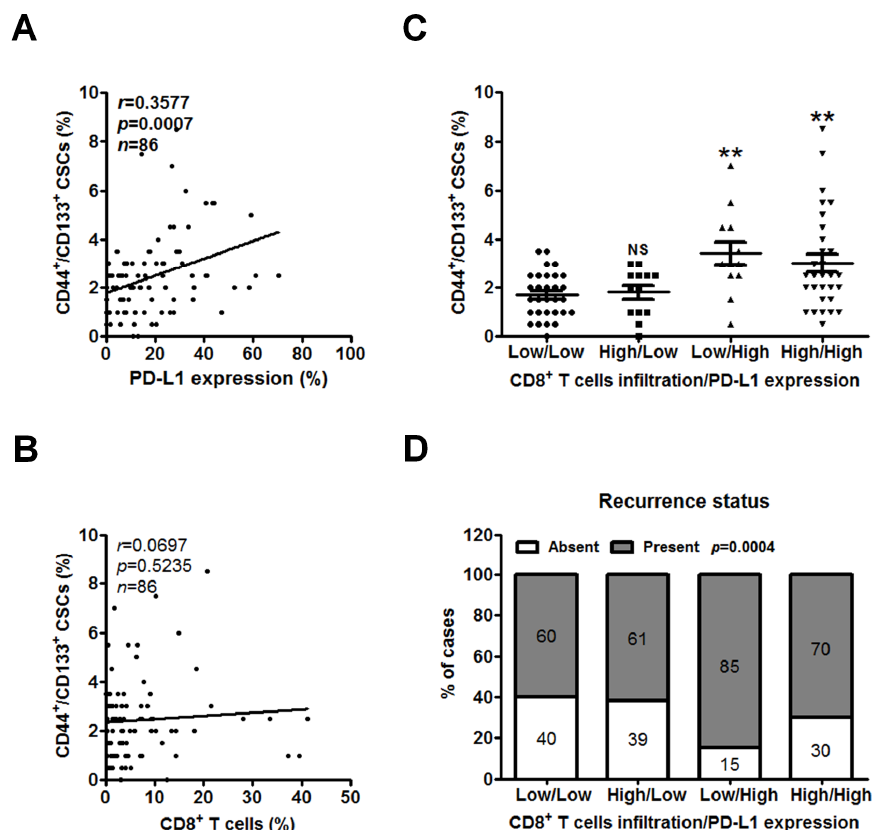
Figure 4. Low CD8 + T cell infiltration and high PD-L1 expression are associated with CSCs and related to the recurrence of PC. ( A , B ) The PC TMAs were double IF stained for CSC markers CD44 and CD133 and further assessed by quantitative analysis. Correlation of percent CD44 + / CD133 + CSCs with PD-L1 expression ( A ) or percent CD8 + T cells ( B ) per patient was analyzed by Pearson’s correlation. ( C , D ) Classification of tumors based on CD8 + T cells infiltration and PD-L1 expression into 4 groups including low CD8 + T cells infiltration / low PD-L1 expression ( n = 30), high CD8 + T cells infiltration / low PD-L1 expression ( n = 13), low CD8 + T cells infiltration / high PD-L1 expression ( n = 13), and high CD8 + T cells infiltration / high PD-L1 expression ( n = 30). ( C ) Dot plots showing the percentage of CD44 + / CD133 + CSCs in each group. All values are the mean ± s.e.m. NS, not significant; **, p < 0.01 compared with low CD8 + T cells infiltration / low PD-L1 expression group, as determined using one-way ANOVA. ( D ) Relative distribution analysis of PC patients’ recurrence status within each group. Absent, patients without recurrent PC; present, patients with recurrent PC. p values calculated using Chi-square test. CSCs, cancer stem cells.